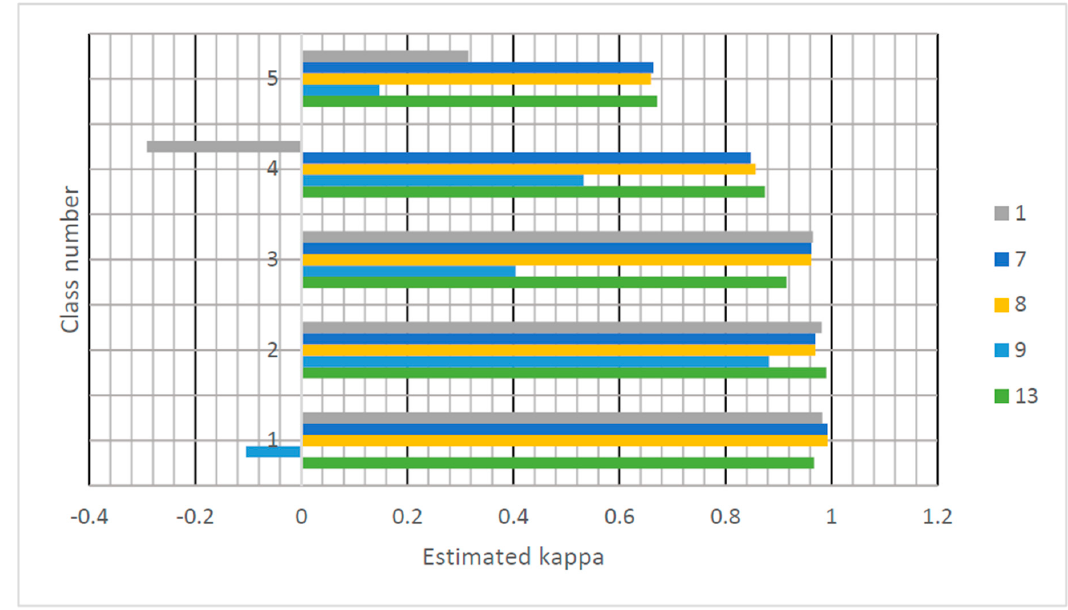
Figure 5. The estimated kappa for the Varaždin study area.